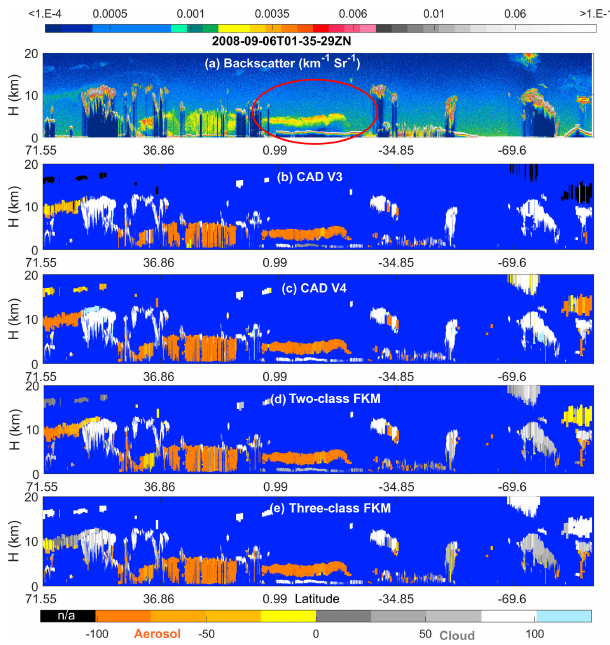
Figure 4. Nighttime orbit segment from 6 September 2008, begin- ning at 01:35:29UTC. The upper panel (a) shows 532nm atten- uated backscatter coefficients. The panels below show the CAD results as determined by (b) the V3 operational CAD algorithm, (c) the V4 operational CAD algorithm, (d) the two-class FKM CAD algorithm, and (e) the three-class FKM CAD algorithm. The red el- lipse in the upper panel highlights a dense smoke layer lying above an opaque stratus deck. In the CAD images (b–e) , stratospheric lay- ers are shown in black, cirrus fringes are shown in pale blue, and regions of “clear air” where no features were detected are shown in pure blue. Latitude units are in degrees; positive: north, negative: south.